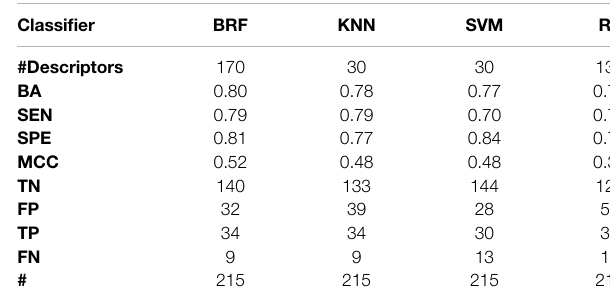
TABLE 3 | Performance of the best models developed on the HSE + LSE/NSE + INA partitioning scheme on the TeS. For each model, the following statistics are reported: Balanced Accuracy (BA), Sensitivity (SEN), Speci fi city (SPE), Matthews Correlation Coef fi cient (MCC), number of True Negatives (TN),